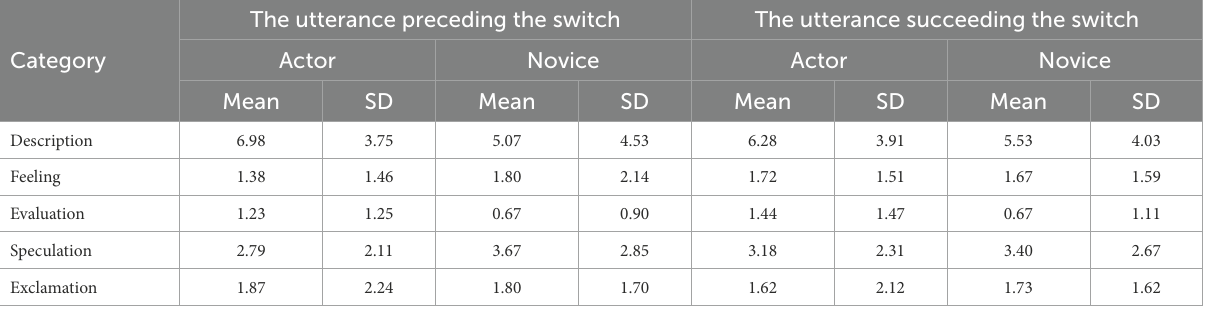
TABLE 5 Descriptive statistics for each kind of switch in each session for novice actors ( Card or Puzzle session) and professional actors ( Activity session).